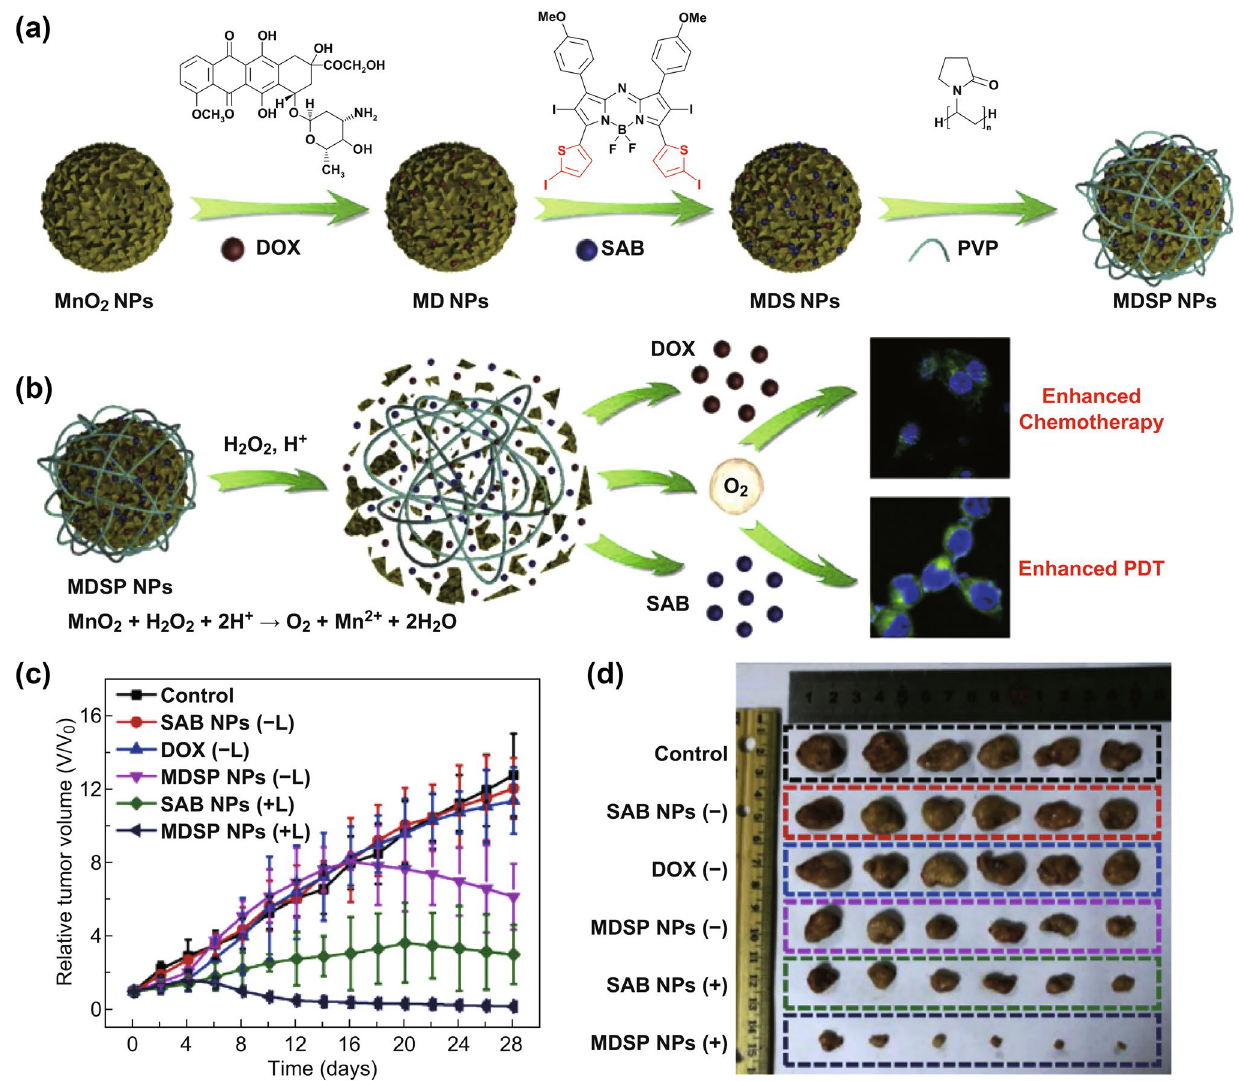
Fig. 2 a Schematic diagram of MDSP NPs manufacturing. b Schematic illustration of MDSP NPs for TME-responsive chemo/photodynamic therapy. c Tumor growth curves of differently treated mice (6 mice/group). d Tumor photographs collected from mice in different treatment groups. Adapted with permission from Ref. [21]. Copyright 2019 Elsevier